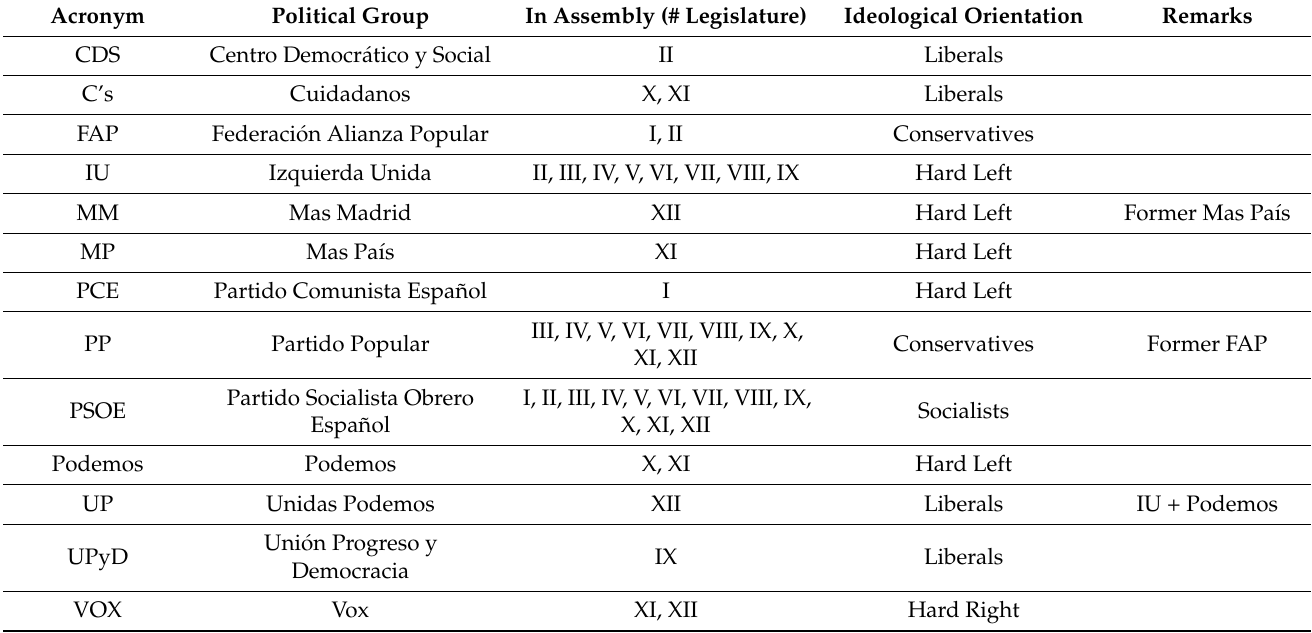
Table A2. Acronyms of Political Groups, legislatures and